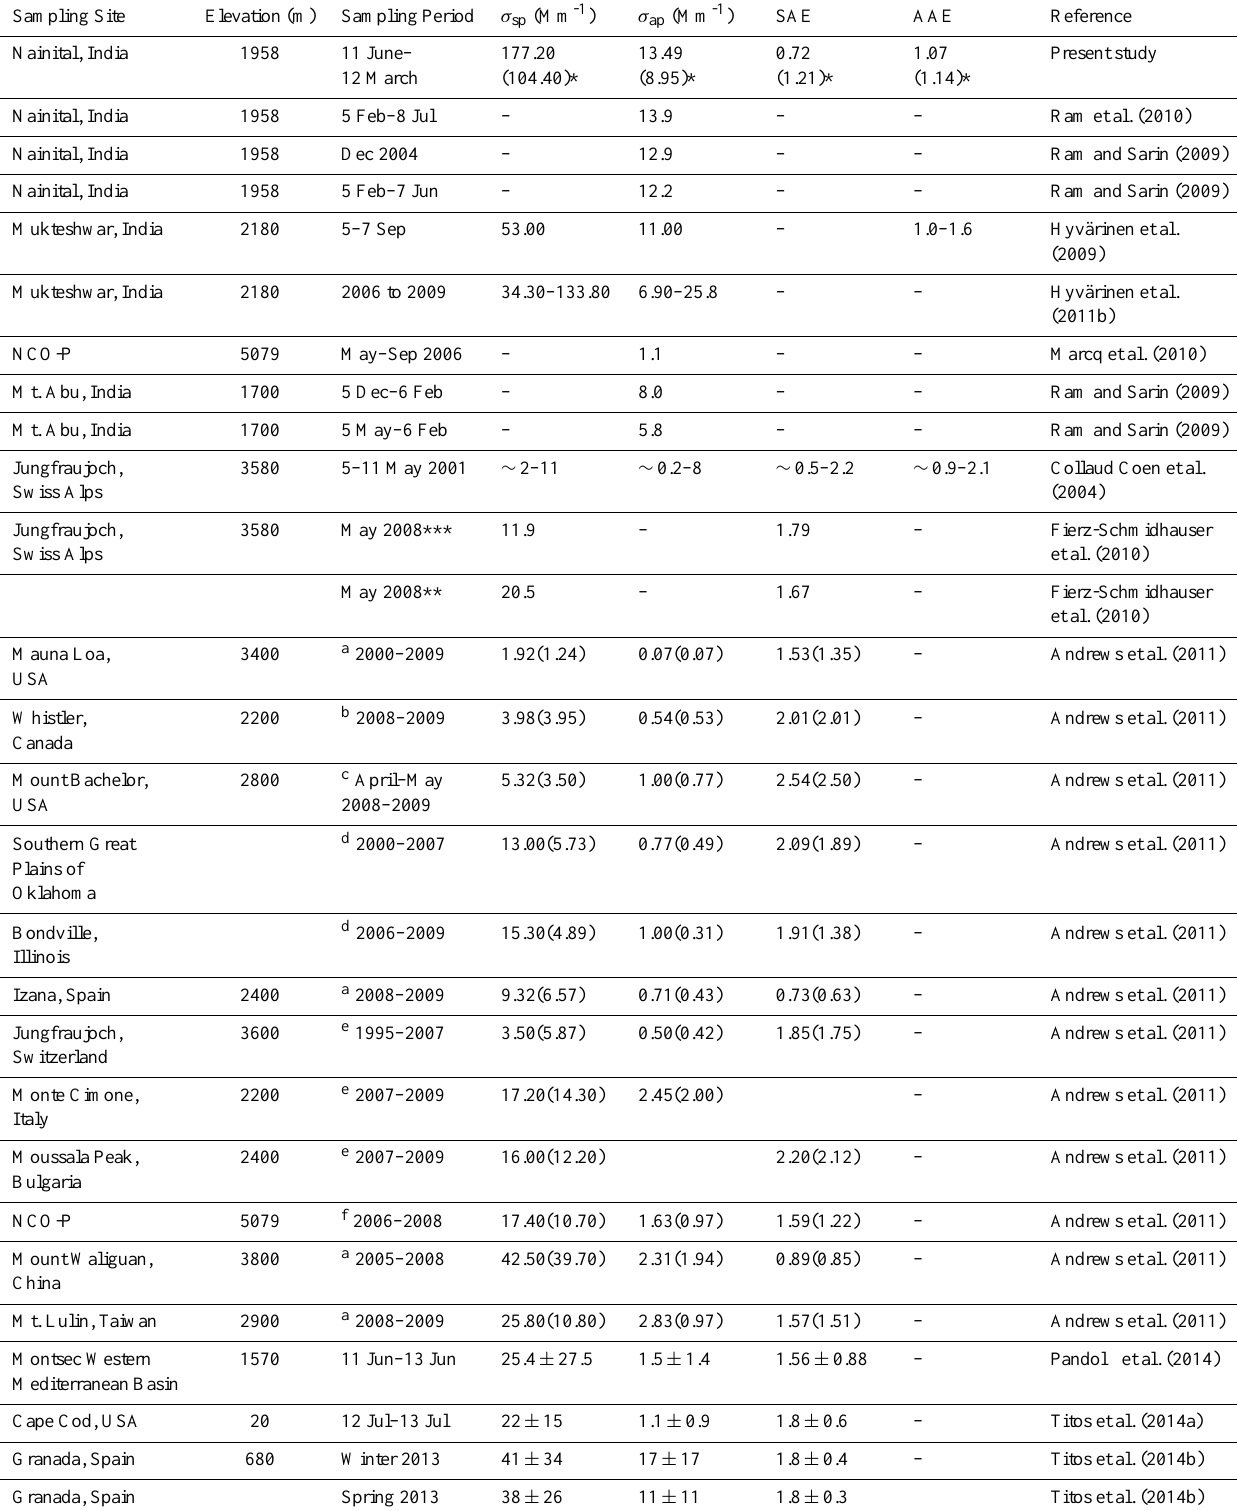
Table 3. Comparison of extensive and intensive aerosol properties over Nainital during the GVAX campaign along with those measured over mountainous or remote areas over the